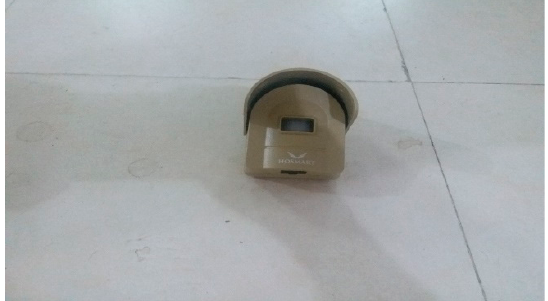
Figure 7. Sensor. Figure 7.